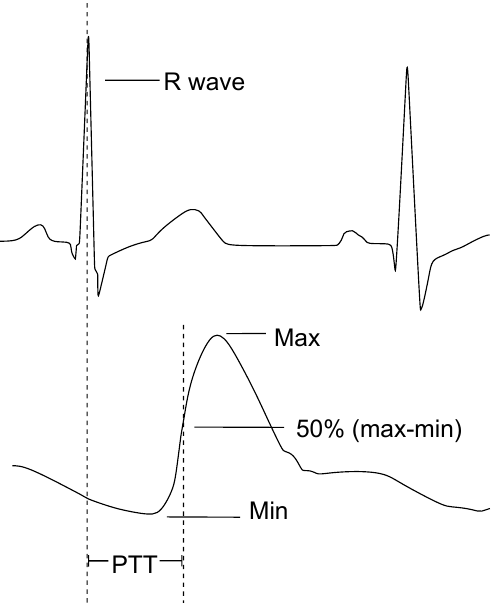
Figure 2. Graphical illustration of the Pulse Transit Time (PTT) using an electrocardiographic ( above ) and photoplethysmographic ( below )